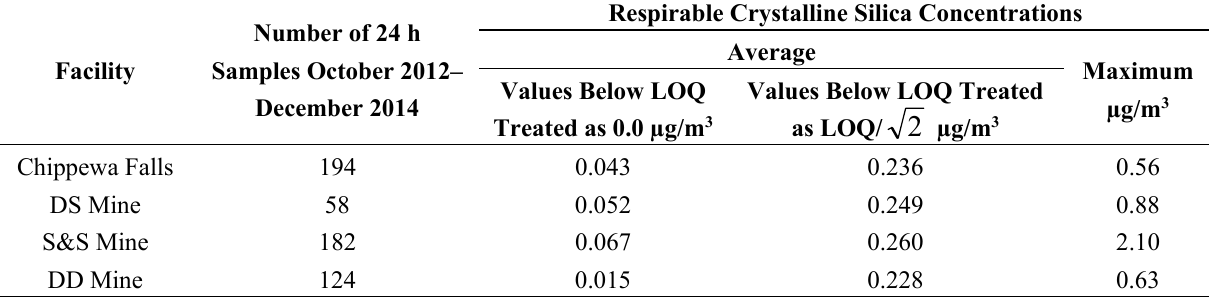
Table 4. Local background